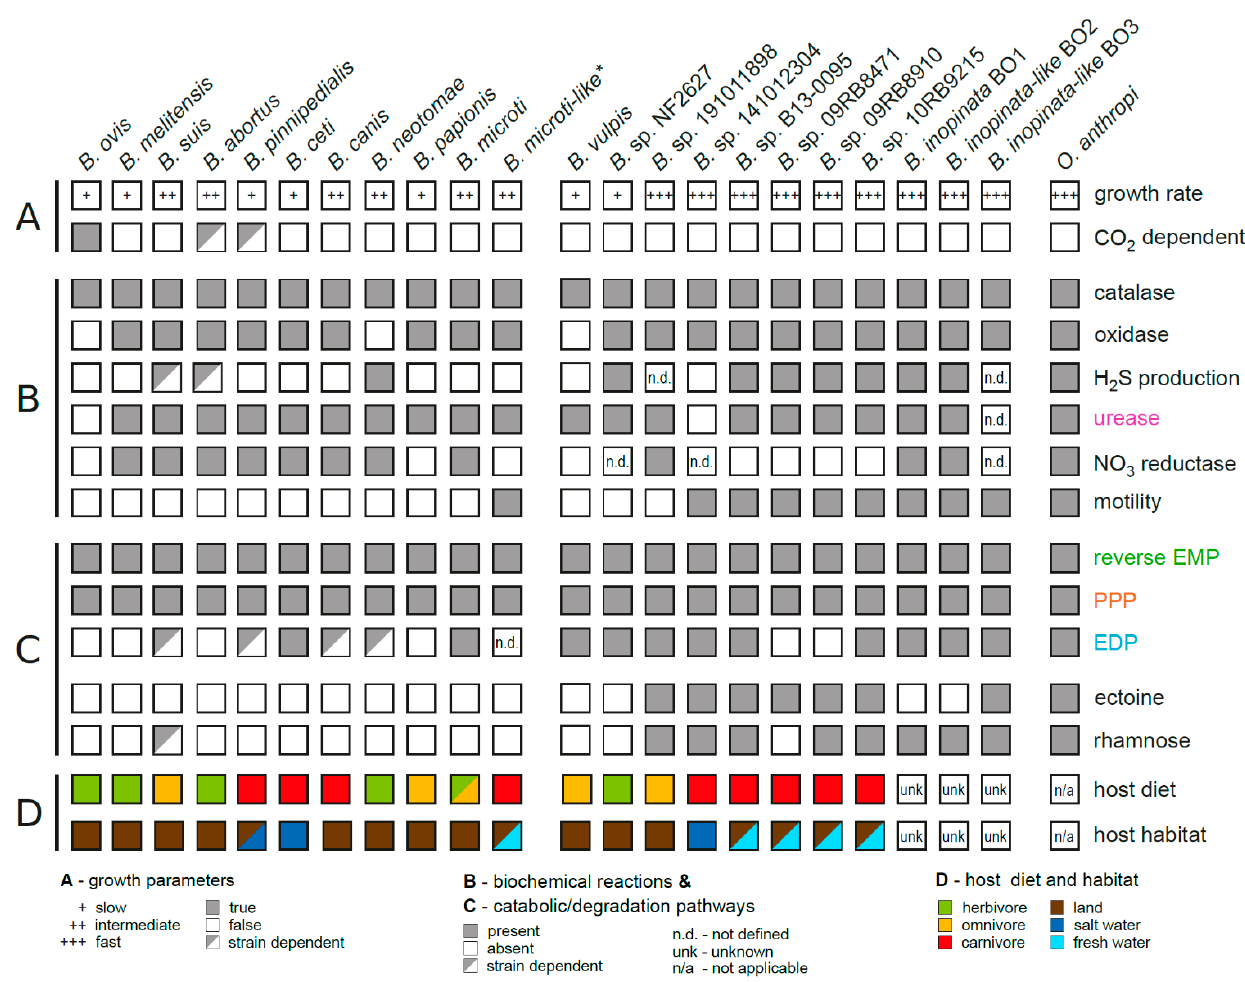
Figure 3. Characteristics of classical and novel Brucella strains and species. Shown are the phenotypic properties of Brucella species and strains, including former O. anthropi ( A , B ), the presence or absence of metabolic pathways in Brucella ( C ), and the typical habitats and diets of Brucella host organisms ( D ). *: B. microti -like strain